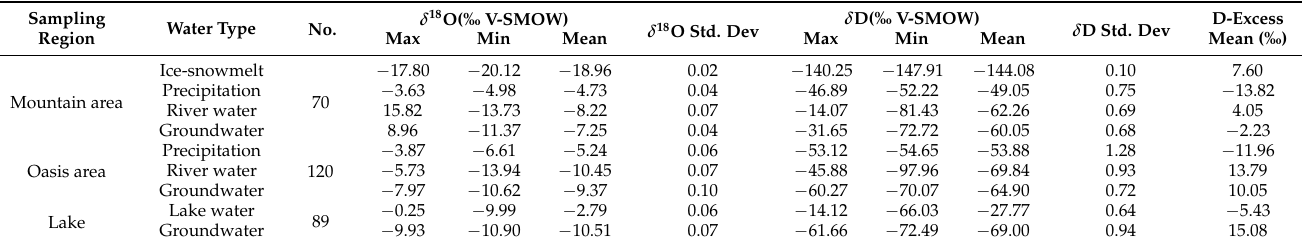
Table 1. The statistics for δ 18 O, δ D, and deuterium excess of different types of water from the Kaidu River (recharge areas of the source to